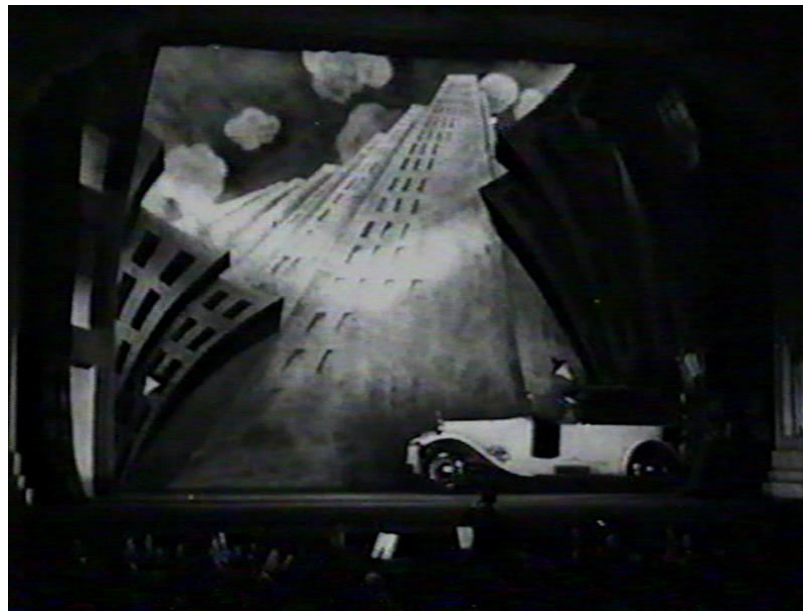
Figure 4. A skyscraper dominates the expressionistic urban nightworld at the beginning of the “Puttin’ on the Ritz”